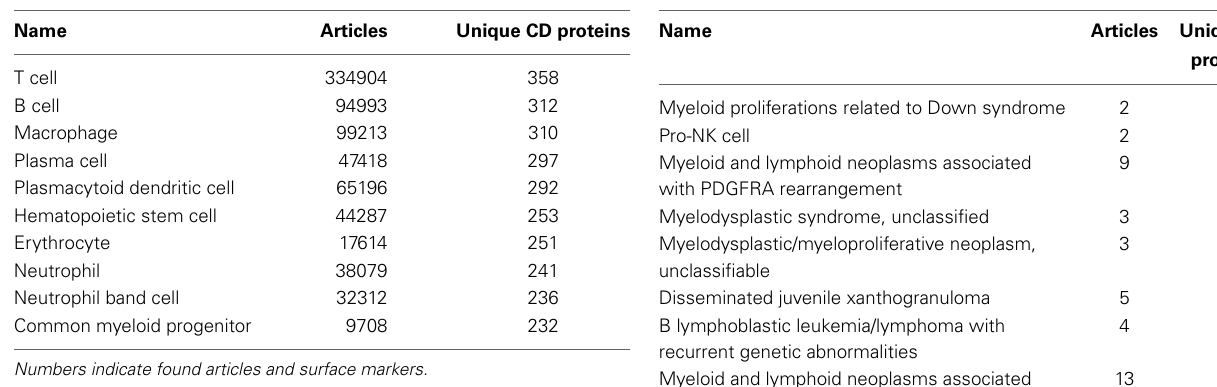
for the cell and CD molecule combination, the shades of blue corresponds to 10–100 hits (light to dark), and green corresponds to 1000 + hits. See Supplementary Figure 1 for high-resolution figure with row and column names.